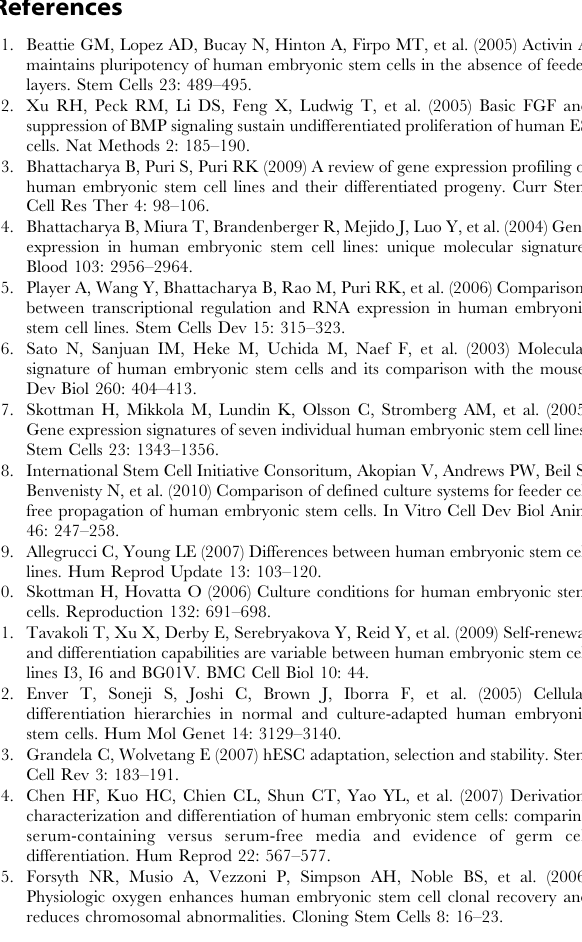
Table S3 Genomatix output generated from CEL files (GEO: